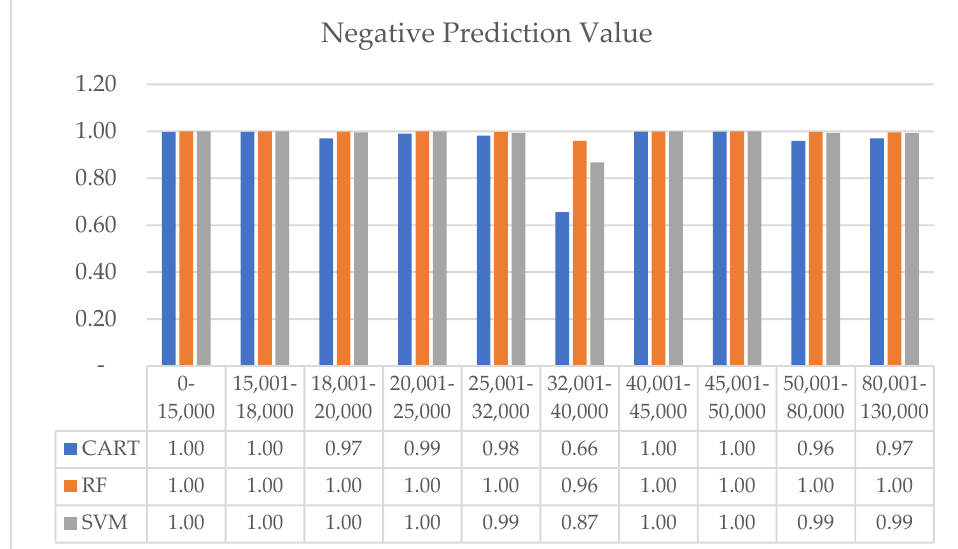
Figure 9. The positive prediction values distribution of all models.